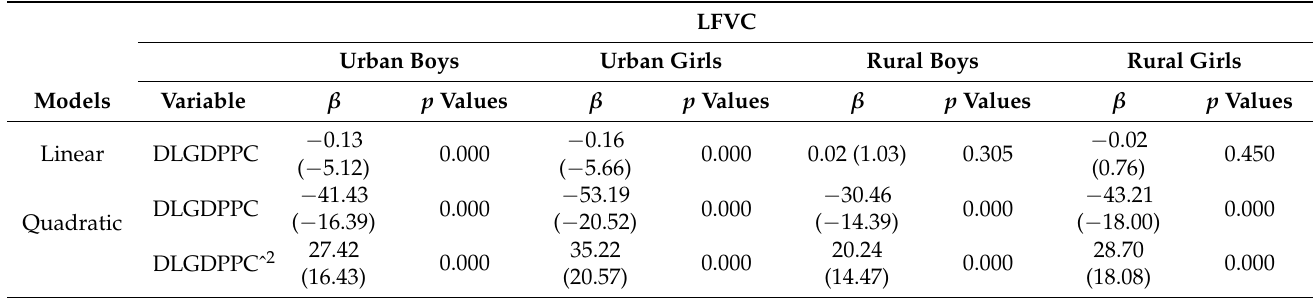
Table A1. Econometric Estimates of the Relationship between Economic Growth Rate and Lung Function of Students. LFVC Urban Boys Urban Girls Rural Boys Rural Girls